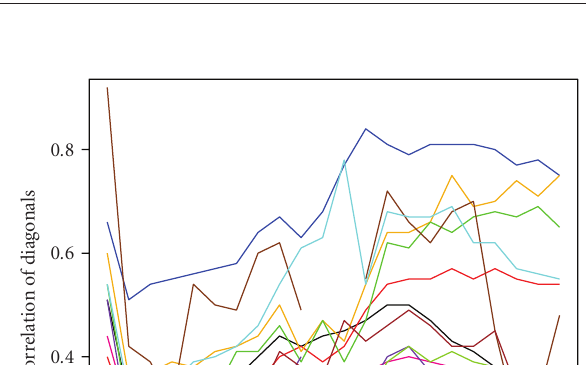
Between − 0 . 5 and 0.5